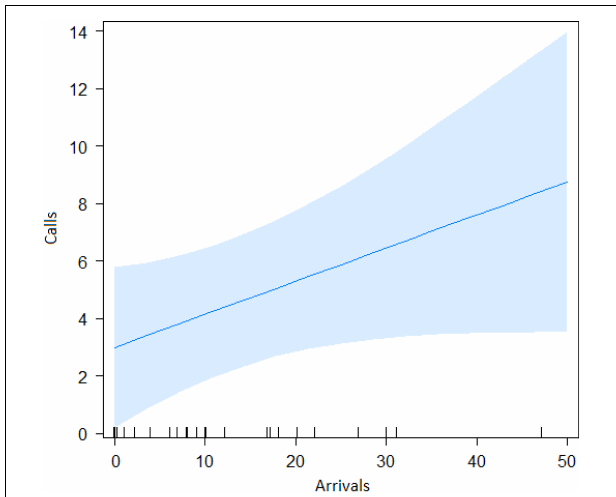
FIGURE 8 | Consequence of alarm calling. Effect of the number of calls given on the number of individuals that arrive at the snake